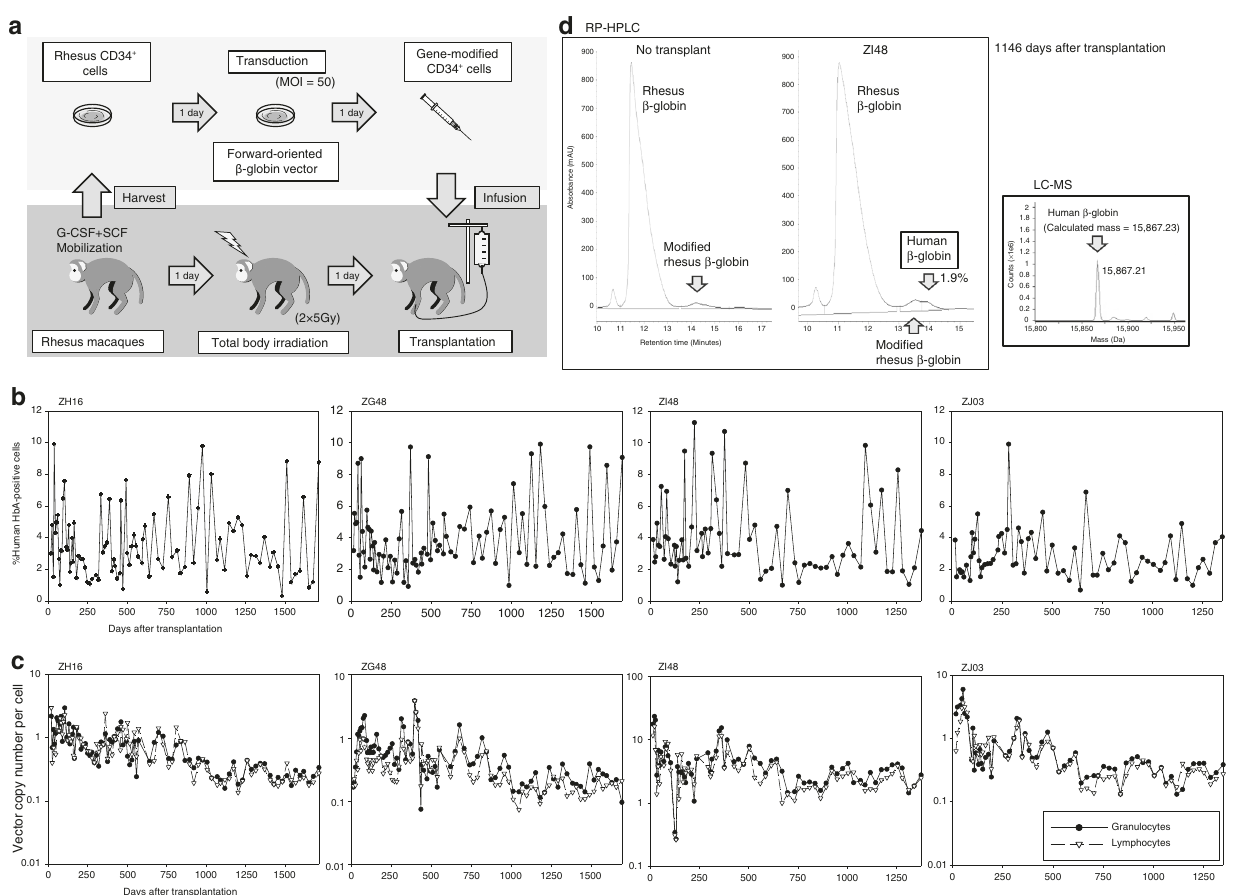
Fig. 5 Detectable human β -globin production at the protein level with the forward-oriented β -globin vector in rhesus transplantation. a We transduced rhesus CD34 + cells with the optimized forward-oriented β -globin vector (with RRE-based intron 2 selection) at MOI 50, and these cells were transplanted into autologous animals (ZH16, ZG48, ZI48, and ZJ03) following 10 Gy total body irradiation. b In all animals, human β -globin expression was analyzed in RBCs for 4 years post transplant, evaluated by a human HbA antibody in fl ow cytometry. c Gene marking levels were evaluated in both granulocytes and lymphocytes up to 4 years. d Three years post transplant in ZI48, human β -globin production in RBCs was evaluated at the protein level by reversed-phase high-performance liquid chromatography (RP-HPLC) and by liquid chromatography-mass spectrometry (LC-MS). All globin protein analysis experiments were performed in a single